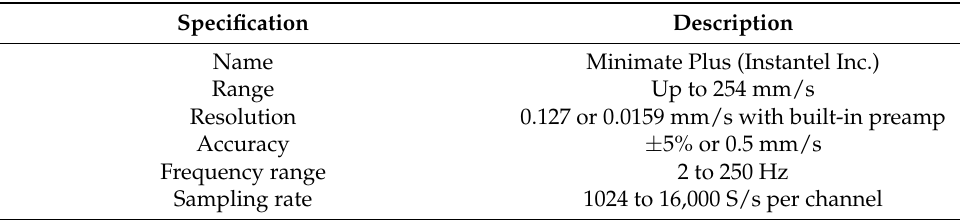
Figure 6. Plan of test blasting and vibration measurement. Table 2. Specification of instruments for measuring vibration.